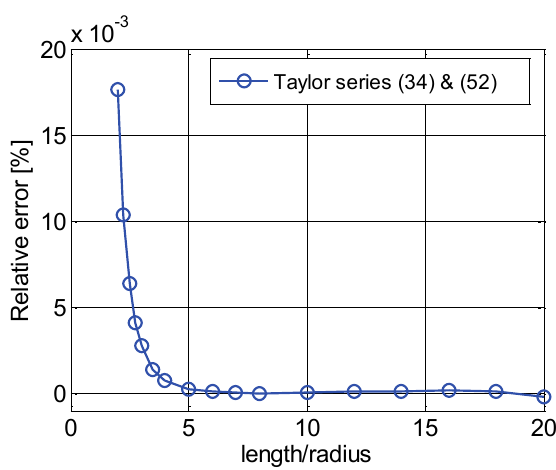
Figure 7: Relative error of formulae (34) and (52) derived with the Taylor series